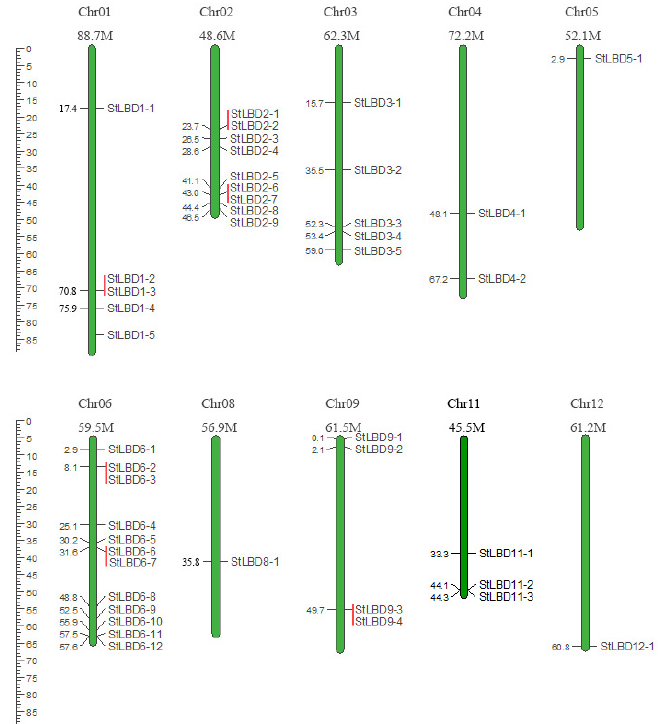
Figure 1. The location of the Lateral organ boundaries domain (LBD) genes in potato on the chromosome. A basic unit represents a chromosome length of 5.0 Mb. The number of each chromosome is marked above